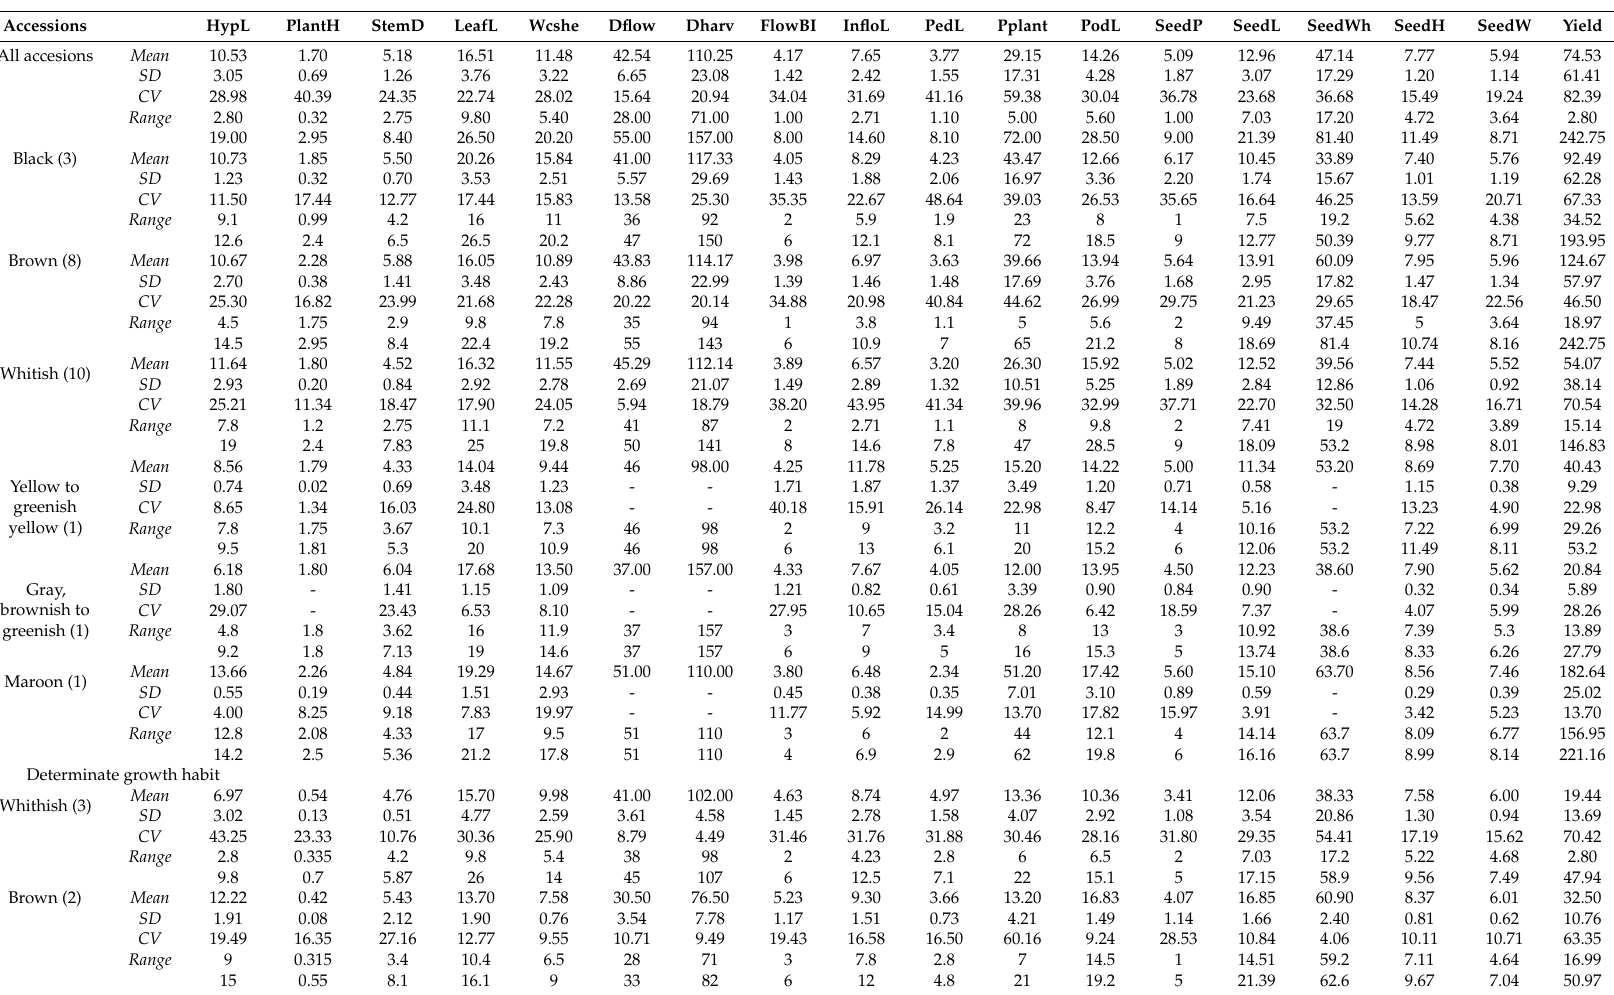
Table 4. Descriptive statistics for quantitative traits in each of the established groups and the whole set of accessions (number of accessions). Autumn growing season. Units of quantitative traits are as defined in Table 1. CV—coe ffi cient of